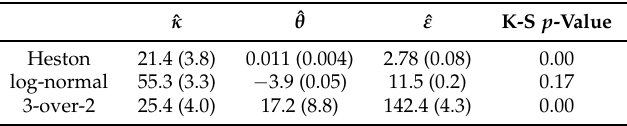
Table 6. S&P 500 ETF data: Estimated parameters, standard errors, and Kolmogorov-Smirnov p -values for realized bipower variation measured